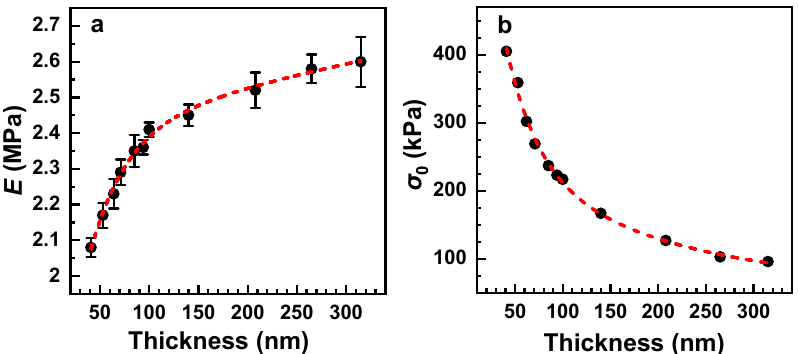
Figure 5. Young’s modulus ( a ) and residual stress ( b ) as functions of the membrane thickness. The experimental points are tentatively traced by the red dashed curves. The data for the thicknesses below and above 60 nm were obtained with the 0.5 mm and 1 mm windows, respectively.